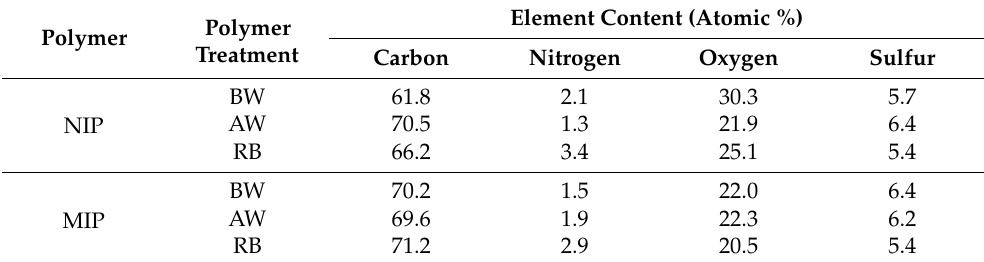
Figure 3. ( a ) CV curves and ( b ) calibration plots of the anodic peak current density change vs. MMP-1 concentration constructed using PA-templated poly(TPARA- co -EDOT) film-coated electrodes in 5 mM K 4 Fe(CN) 6 and 5 mM K 3 Fe(CN) 6 (adapted with permission from Ref. [21]). The anodic peaks were measured in the range of 0.34 to 0.38 V vs. Ag/AgCl. Table 1. Results of EDX elemental analyses of the PA-templated poly(TPARA- co